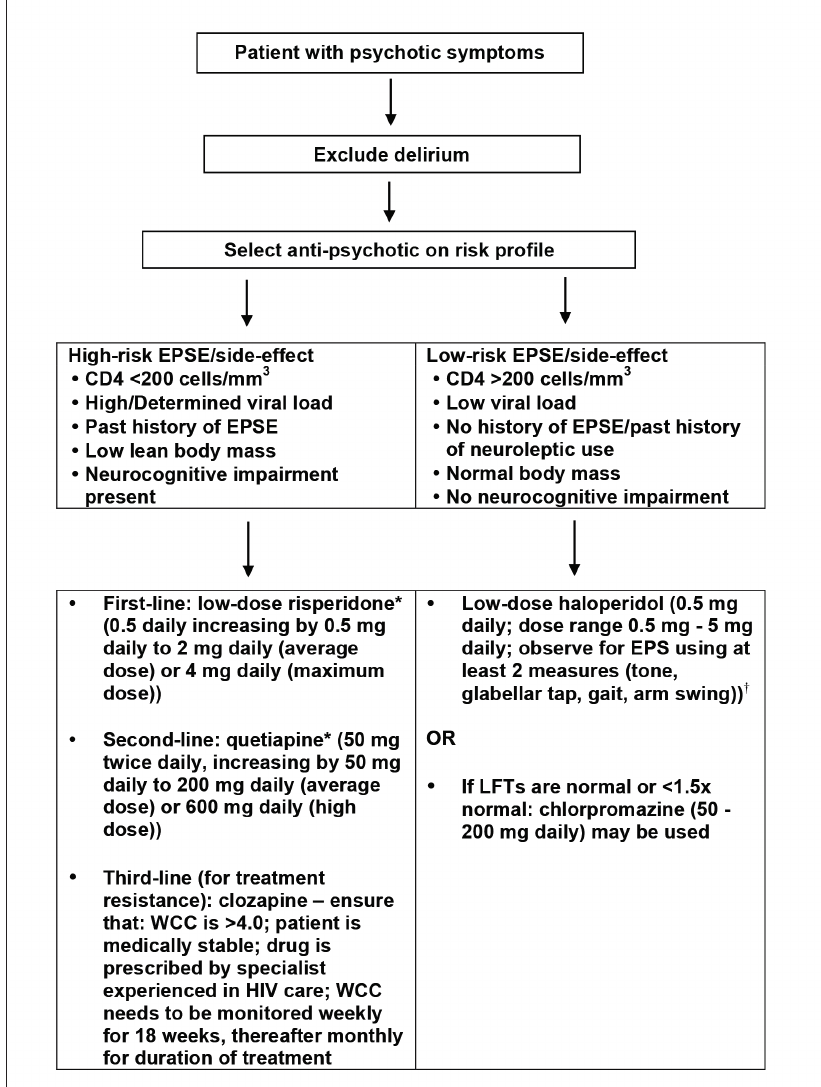
Fig. 1. Decision tree for initiating appropriate anti-psychotic treatment for psychosis in HIV-infected individuals. EPSE = extra-pyramidal side-effects; WCC = white cell count; LFTs = liver function